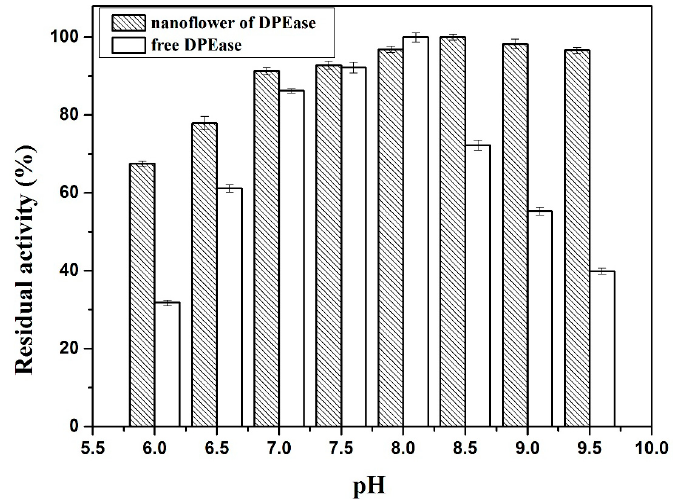
Figure 6. pH stability of nanoflower and free DPEase. Both the free DPEase and the nanoflower were pre-incubated at 4 ◦ C and different pH values for 2.0 h. After this, the residual activity was measured. The DPEase activities at a pH of 8.5 for nanoflower (36.2 U/mg) and at a pH of 8.0 for free DPEase (5.0 U/mg) were both 100%, respectively.